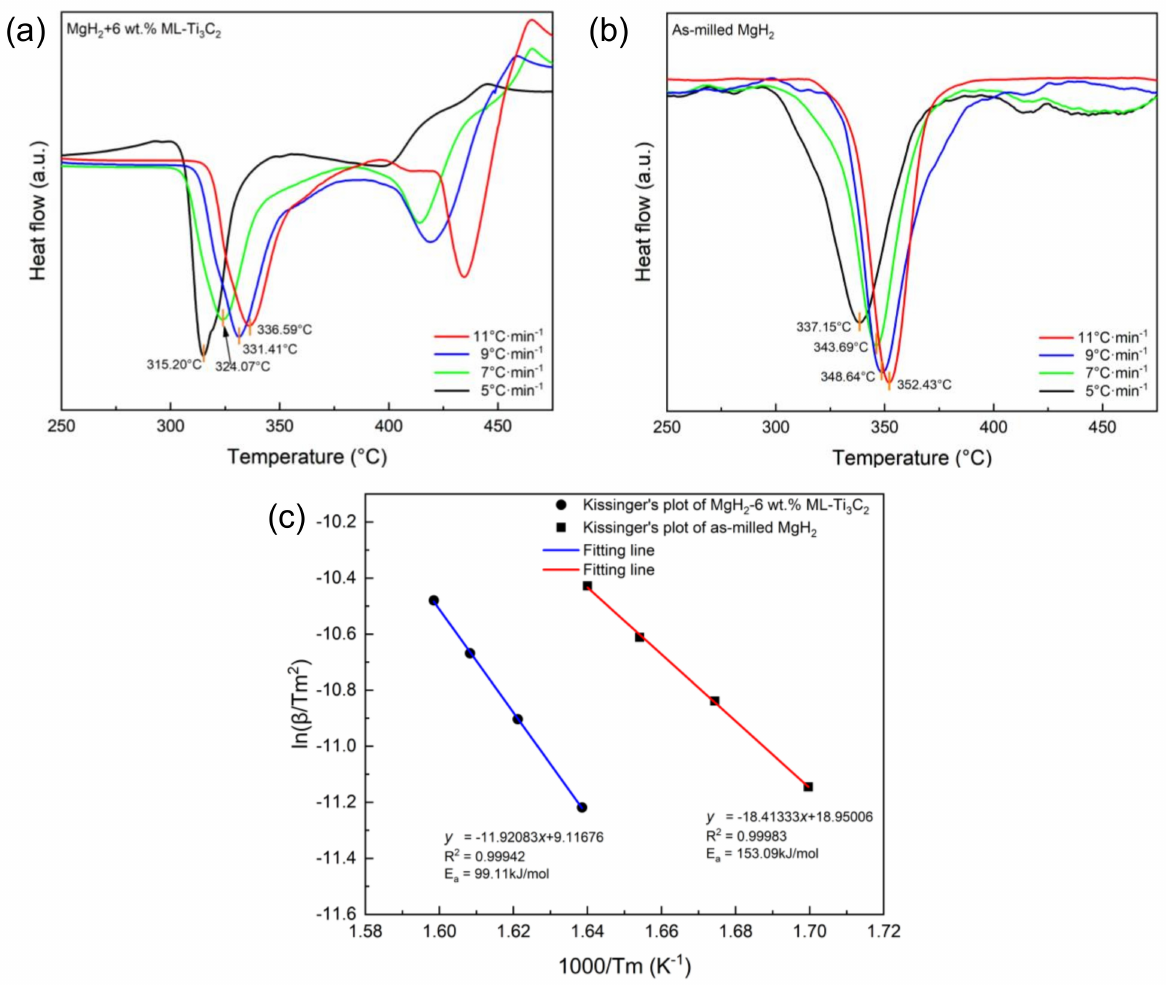
Figure 4. Differential scanning calorimeter (DSC) curves of ( a ) MgH 2 -6 wt.% ML-Ti 3 C 2 and ( b ) as-milled MgH 2 at various heating rates. ( c ) Kissinger’s plots and corresponding fitting lines for MgH 2 -6 wt.% ML-Ti 3 C 2 and as-milled MgH 2